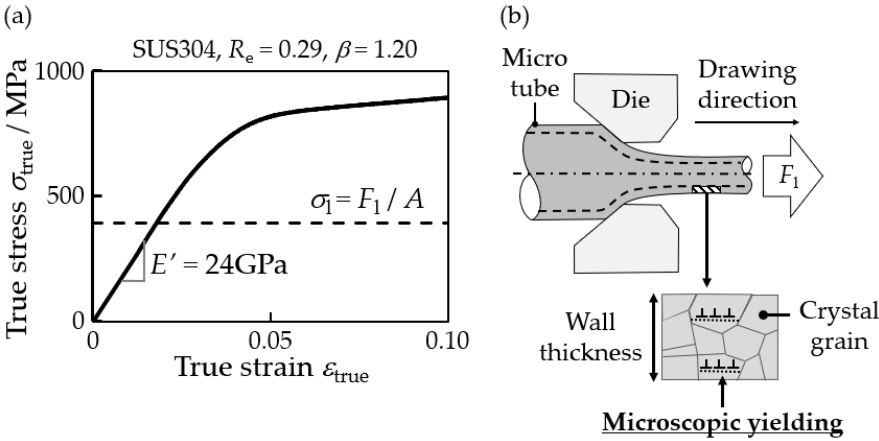
Figure 15. Measurement results of the stress-strain curve and drawing stress during drawing. ( a ) Stress-strain curve of the drawn stainless-steel tube at the die reduction R e of 0.29 and the drawing speed ratio β of 1.20. The dotted line indicates the drawing stress σ l . The parameters F l and A are the drawing tension and the cross-sectional area of the drawn tube, respectively. The parameter E ’ is the apparent elastic modulus of the stress-strain curve. ( b ) Schematic illustration of the microscopic yielding of the drawn micro tube during drawing.